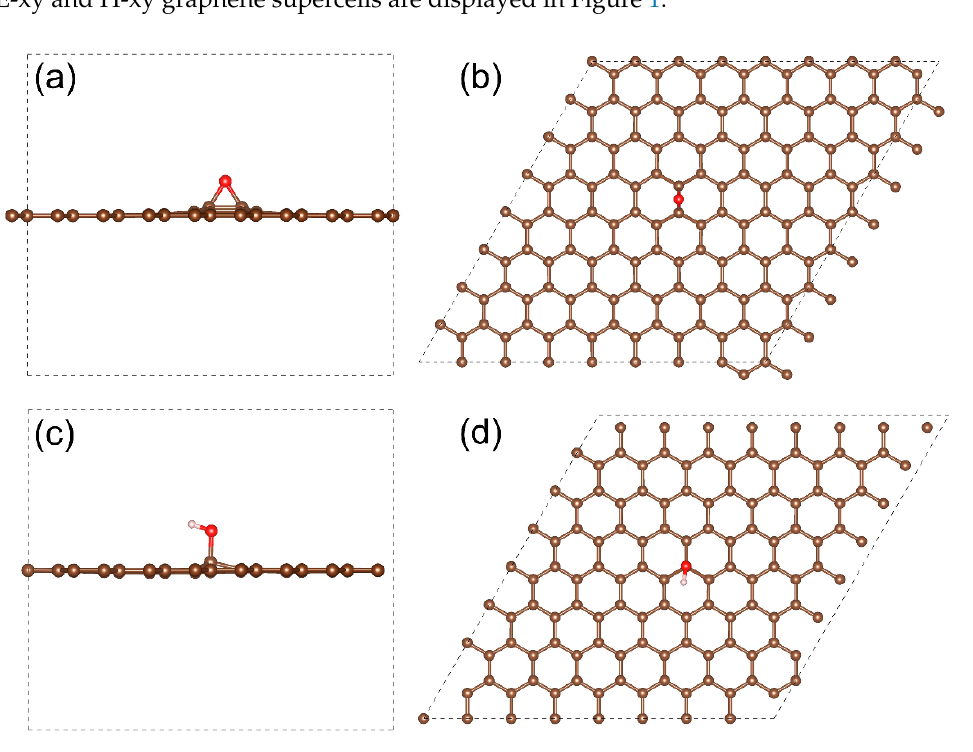
Figure 1. The supercells of the ( a , b ) E-xy graphene and ( c , d ) H-xy graphene taken for the DFT studies, top and side